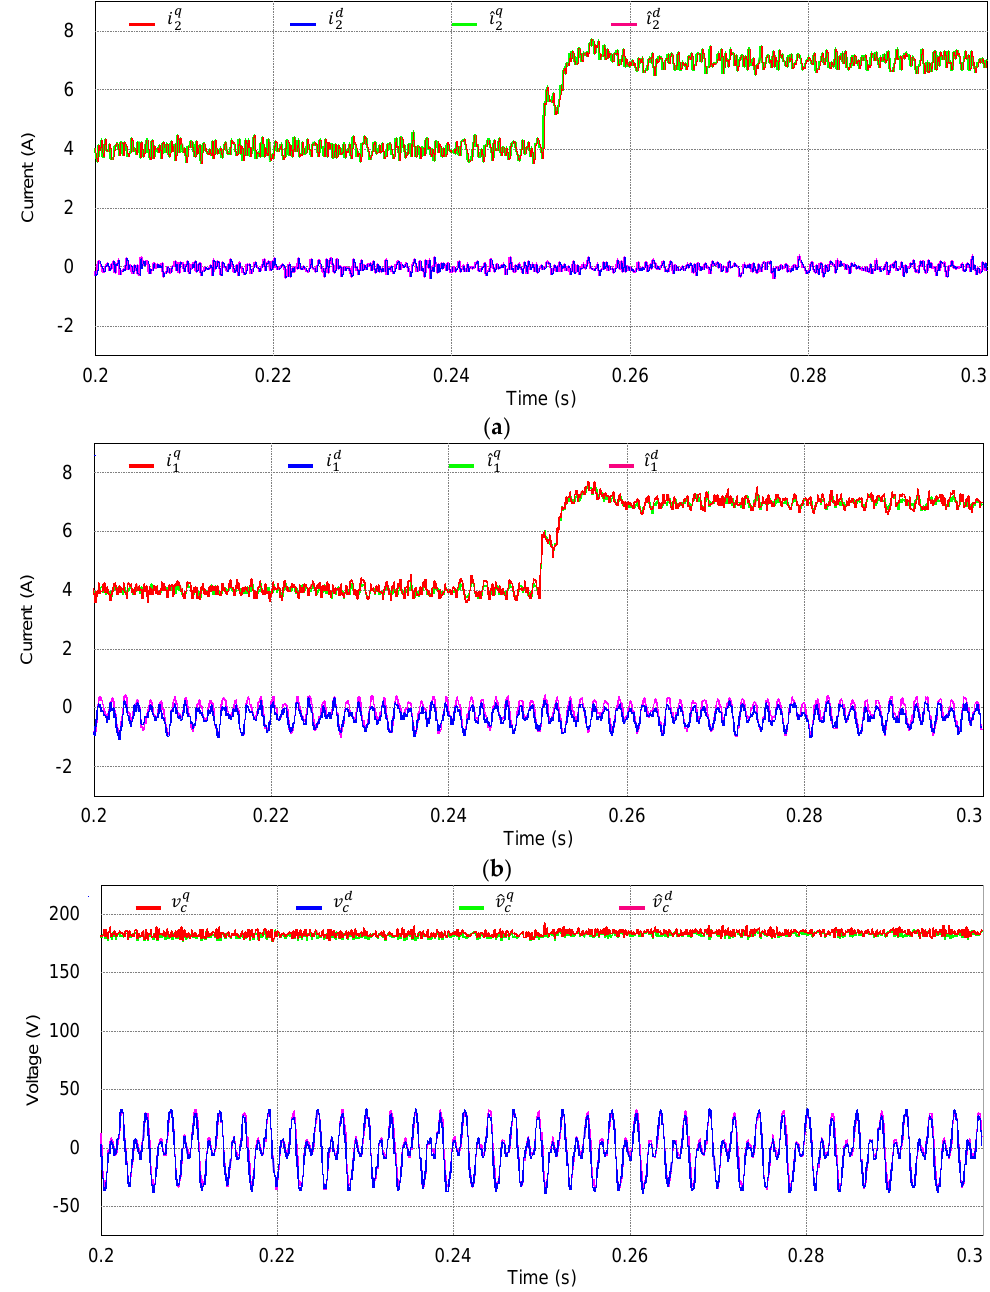
Figure 8. Simulation results for the proposed control scheme with the discrete-time full-state observer under step change in q -axis current reference; states and estimated states. ( a ) Waveforms of grid-side currents and estimated states at the SRF; ( b ) waveforms of inverter-side currents and estimated states at the SRF; ( c ) waveforms of capacitor voltages and estimated states at the SRF. Figure 9 represents the simulation results for measured three-phase variables using the proposed integral-resonant state feedback control scheme with the discrete-time current full-state observer when the q -axis reference current has a step change. As can be seen from Figure 9a,